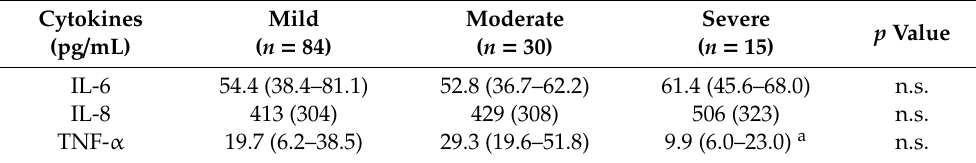
Table 5. Salivary IL-6, IL-8, and TNF- α levels in CF patients with mild, moderate, and severe lung disease.